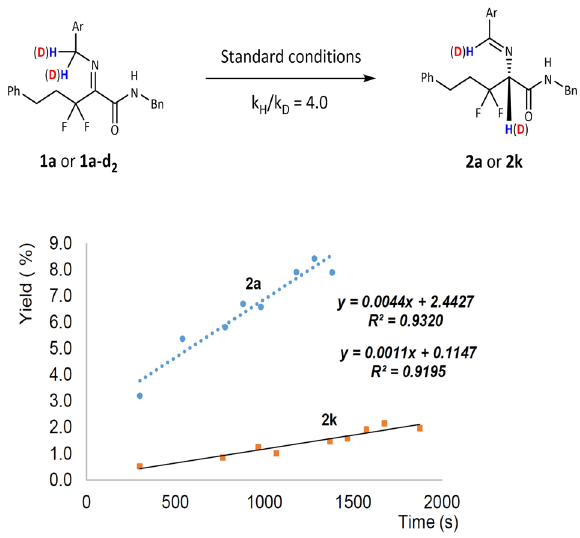
Fig. 5 KIE from parallel experiments. The parallel experiments of 1a and 1a-d 2 .